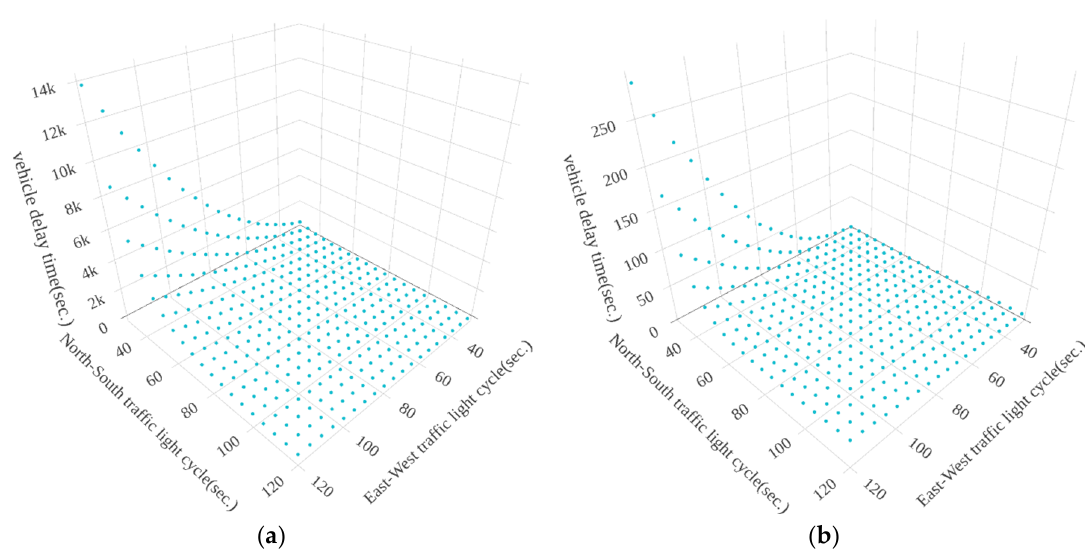
Figure 11. The results of vehicle delay by using exhaustive search method on Huanhe N. Rd and Nanjing W. Rd. ( a ) from 8:00 a.m. to 9:00 a.m. ( b ) from 5:00 p.m. to 6:00 p.m.